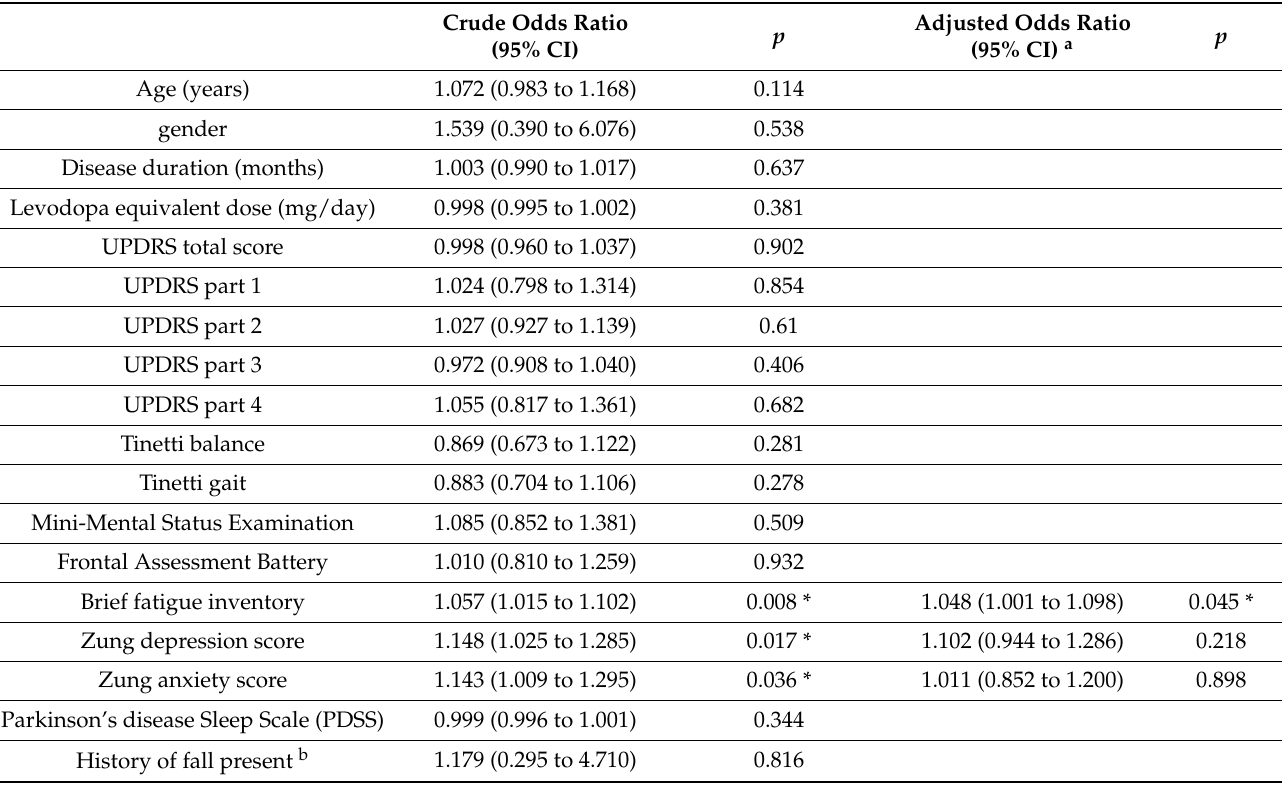
Table 3. Independent predictive variables for disease progression defined by an upgrade of Hoehn-Yahr